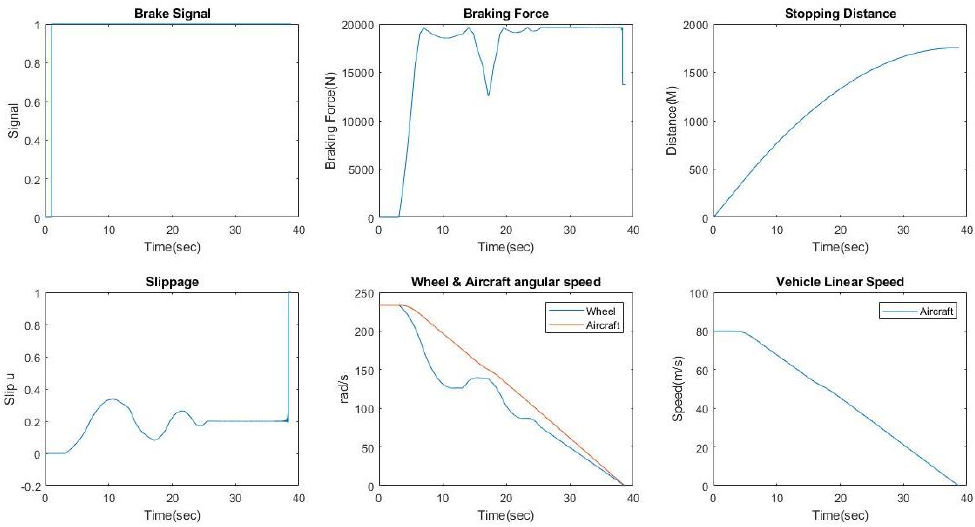
Figure 2. Aircraft Braking Data.